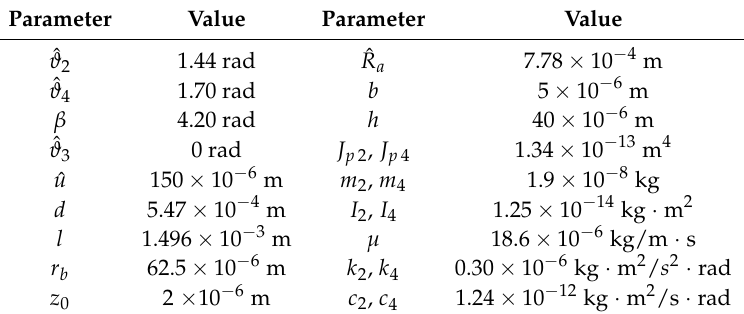
Table 1. Parameter values given in input to the developed